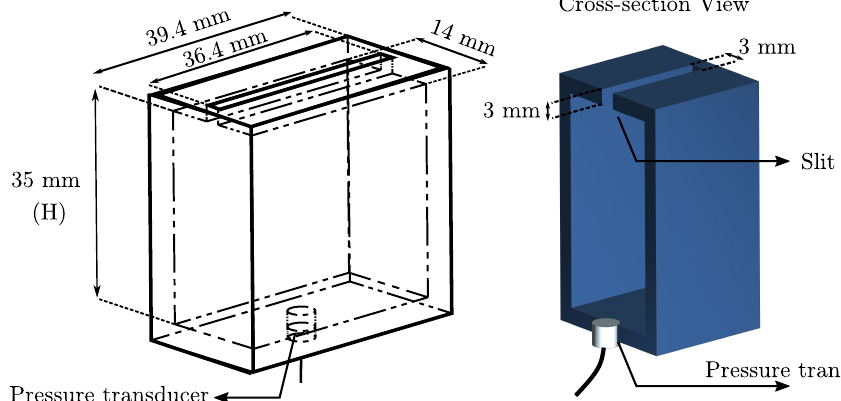
Figure 2. Schematics of a resonator sample with geometrical details and locations of the flush- mounted microphone (pressure transducer) inside the Helmholtz resonator.